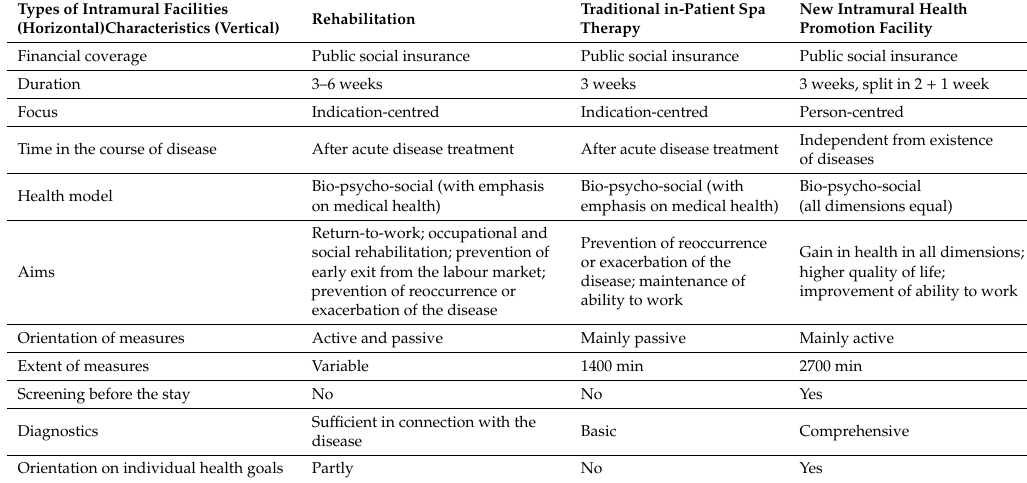
Table 1. Similarities and di ff erences between traditional rehabilitation, traditional spa therapy and the planned intramural health promotion